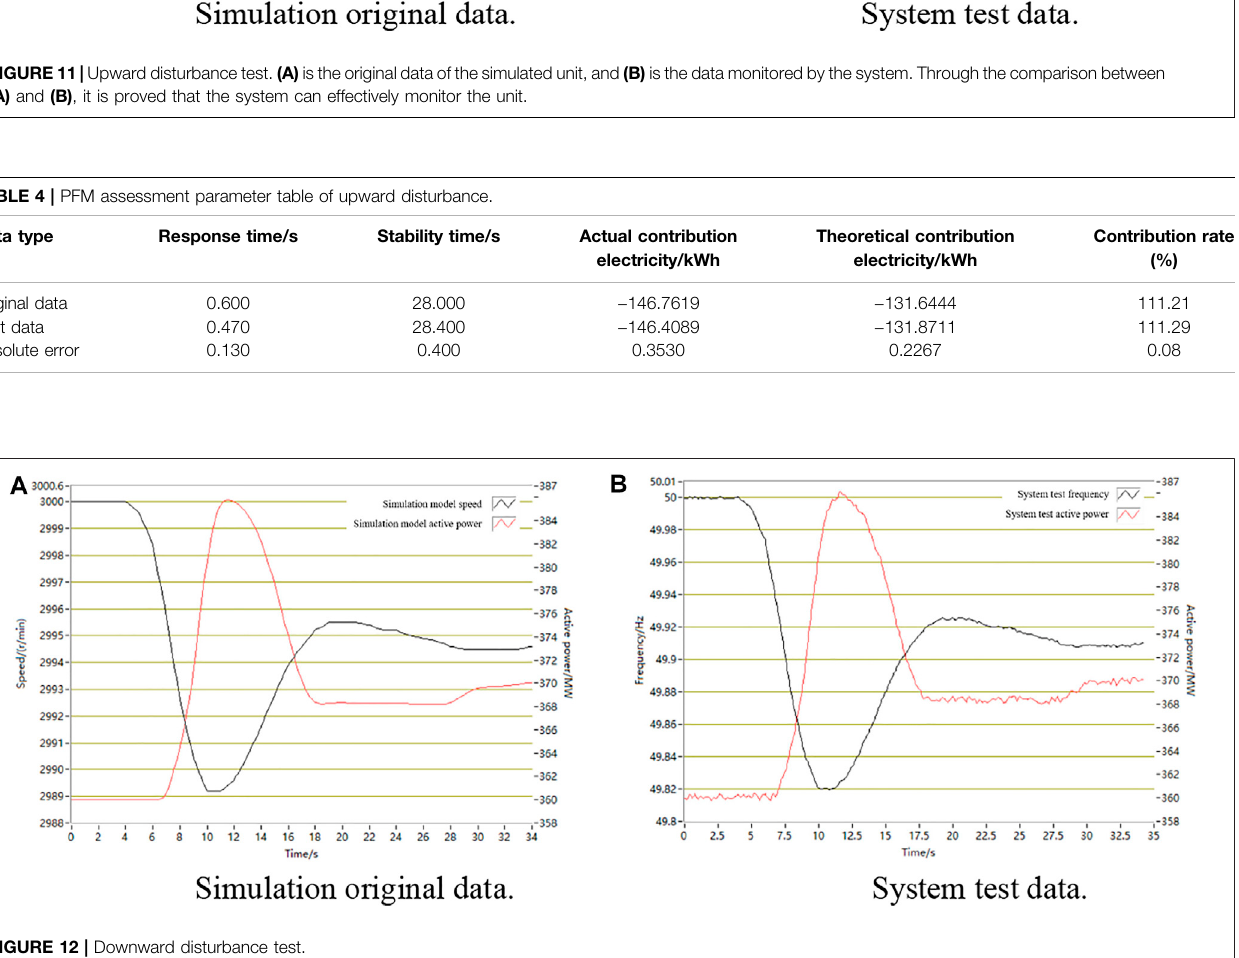
FIGURE 12 | Downward disturbance